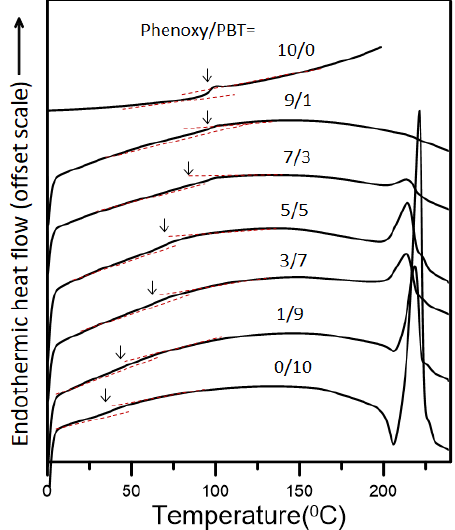
Figure 3. DSC traces of the phenoxy/PBT blends of various compositions annealed at 260 °C for 3 h.